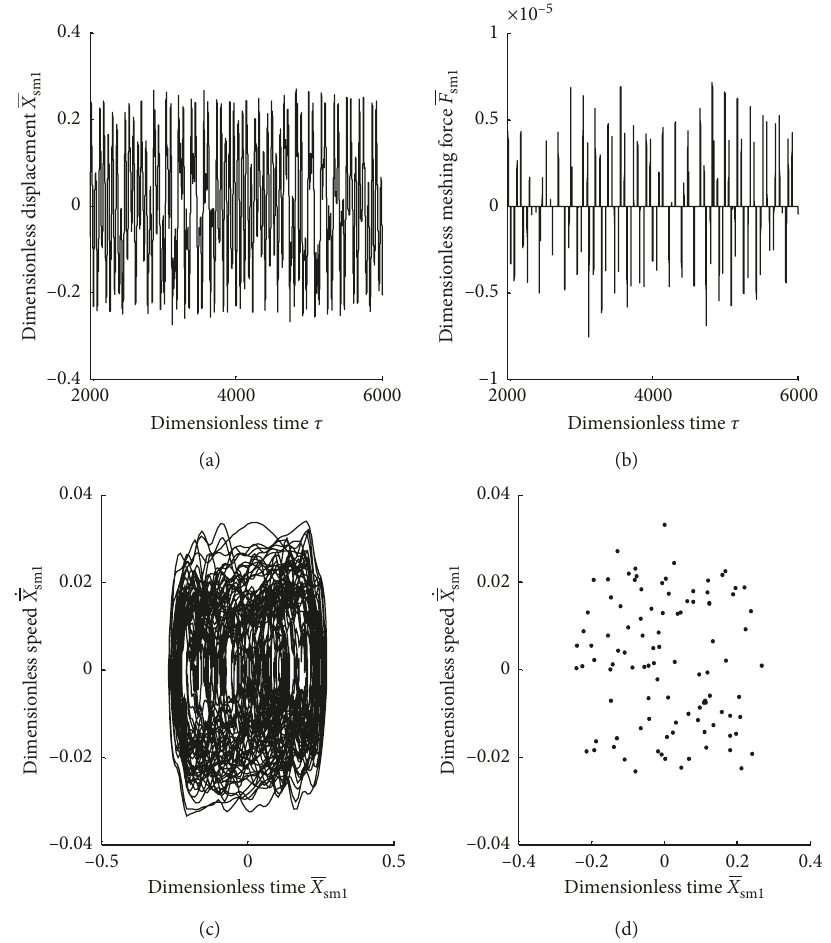
Figure 12: Process diagrams of response, phase diagram, and Poincar´e section under b process diagram of displacement response. (b) Time process diagram of meshing force response. (c) Phase diagram. (d) Poincar´e